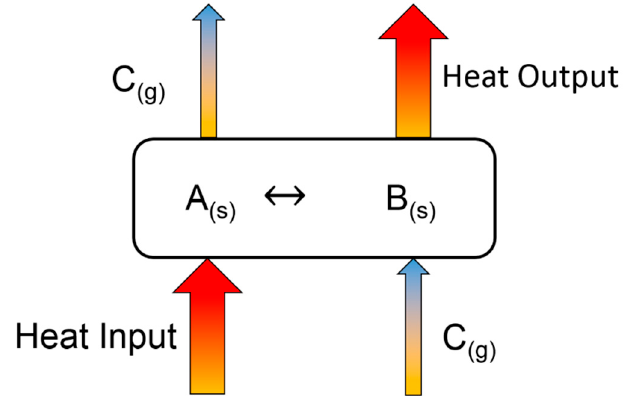
Figure 1. Principle of TCES system.